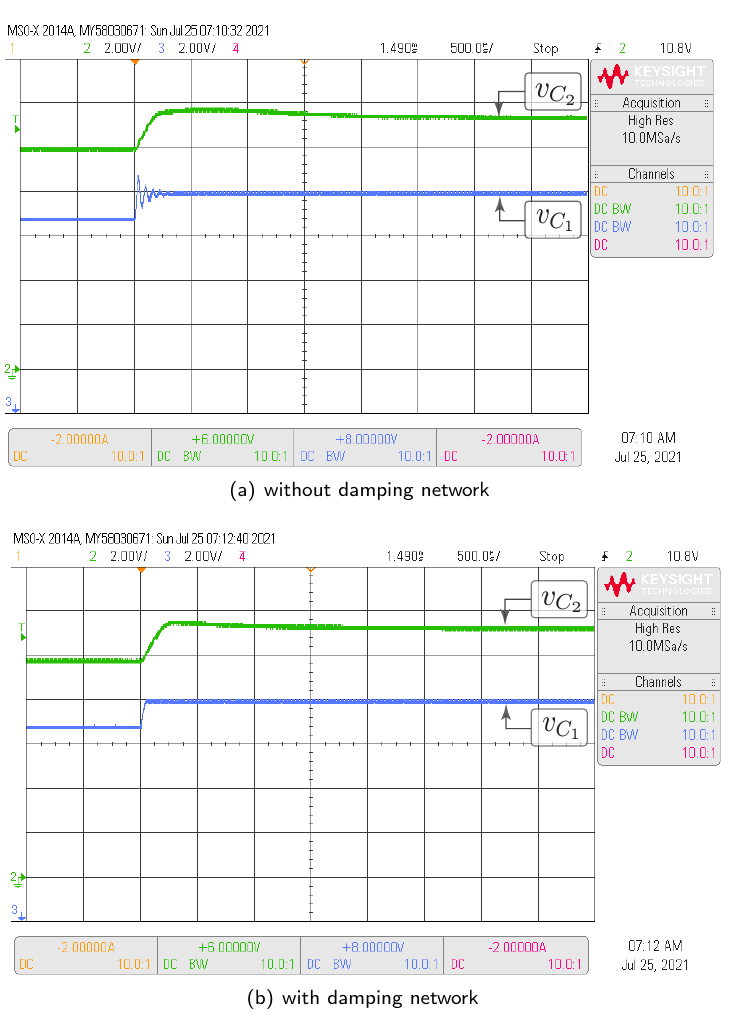
(1 A/div), CH2: v C (10 V/div), CH3: v C (10 V/div), CH4: − i l 2 1 2 1